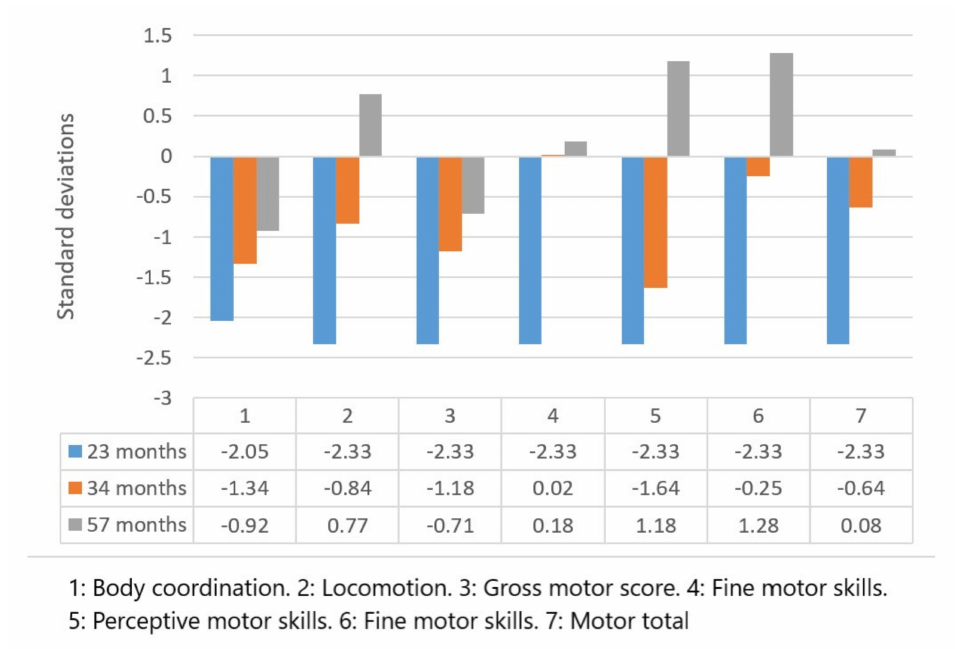
Figure 2. Motor scale scores of the Battelle Developmental